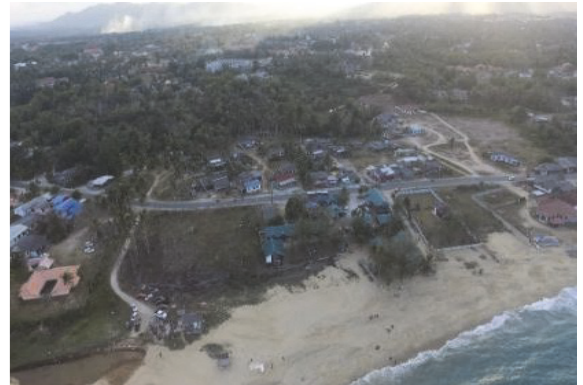
Figure 1: Study area at Pantai Tanjung Gelam,